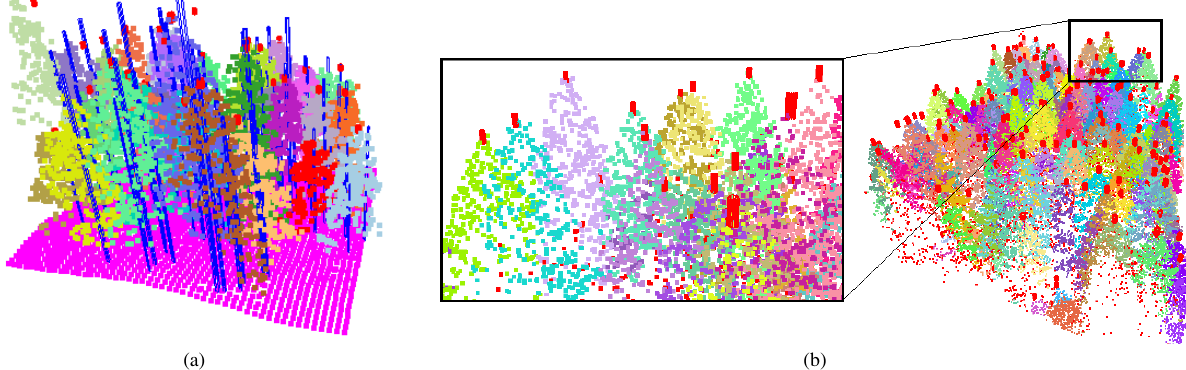
Figure 2. (a) Point cloud of a circular plot from Dataset (I), with marked tree positions from field inventory (blue bars) and manually refined tree top locations (red cylinders). (b) Manually derived tree positions marked within the point cloud of Dataset (II) by red cylinders. Point colors represent single tree clusters.